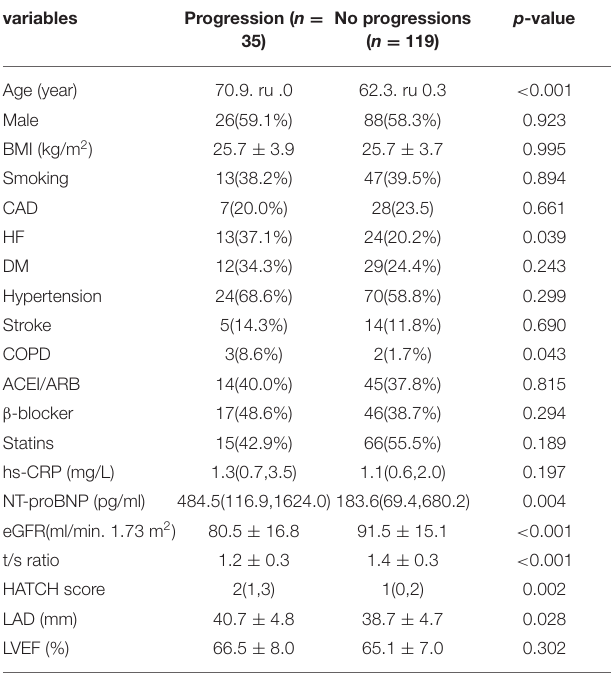
PsAF from patients with PAF. As shown in Figure 2 , LTL shows a significant diagnostic value for distinguishing patients with PsAF from patients with PAF, with AUC = 0.63 (95% CI: 0.56– 0.70), and the optimal cut-off point was calculated as 1.175 with sensitivity and specificity of 56.03 and 82.04%, respectively. All patients with PAF were divided into two subgroups according to the optimal cut-off point calculated by the ROC curve: shorten LTL group (LTL ≤ 1.175) and non-shorten LTL group (LTL > 1.175). Kaplan-Meier curve analysis was used to estimate the difference of the cumulative proportional probabilities of the occurrence of progression between the two groups, as shown in Figure 3 . Patients with shorter LTL had a significantly increased cumulative probability of AF progression than those with longer